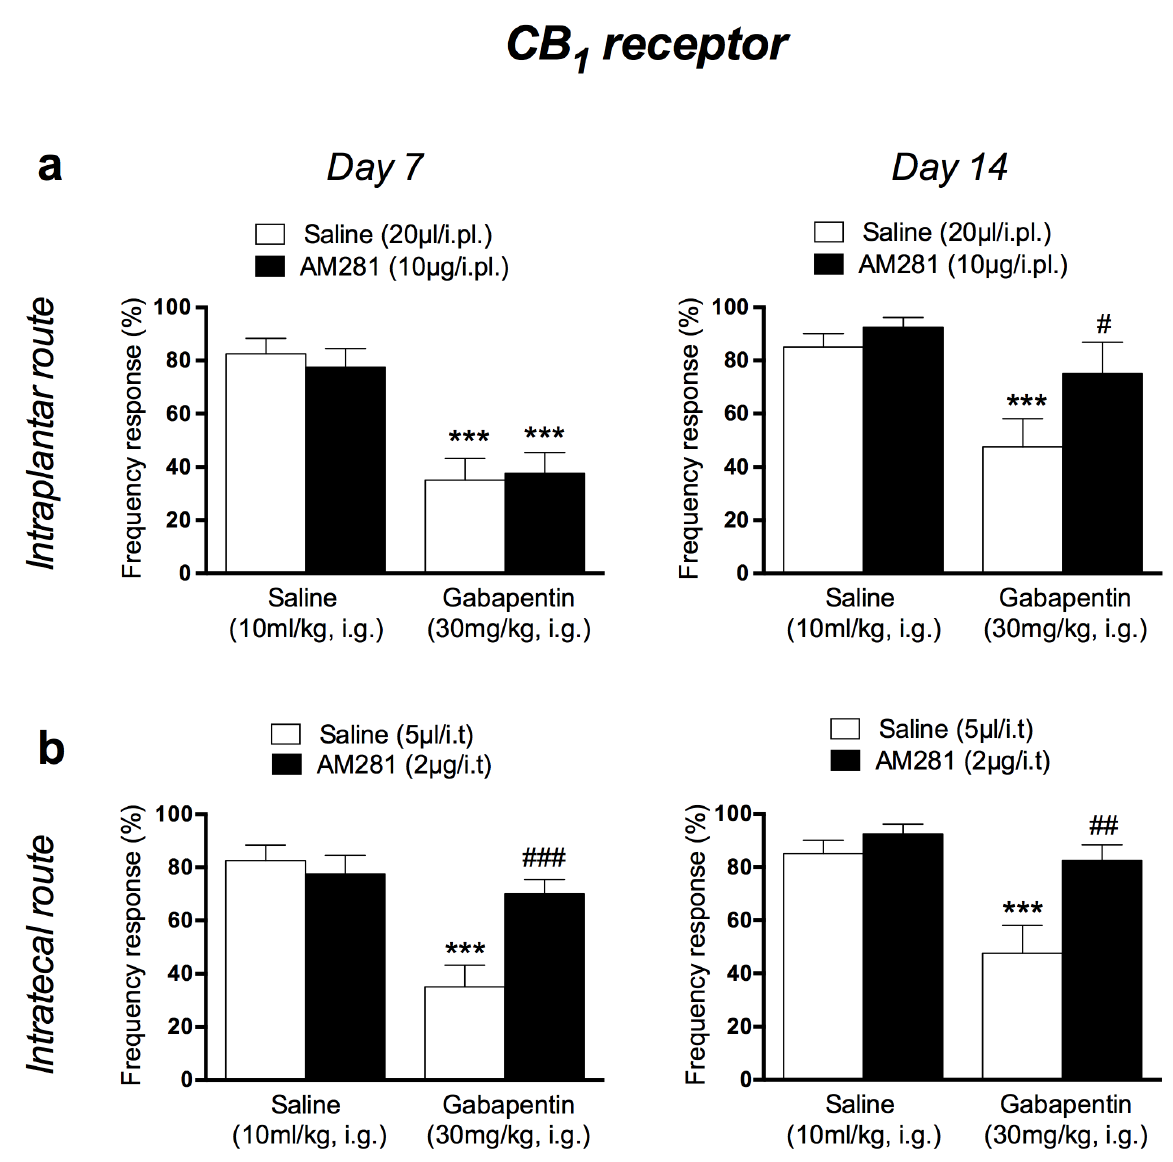
Figure 2. Influence of the CB antagonist, via i.pl. (panel A) or i.t. (panel B), on the antihyperalgesic effect of 1 gabapentin on the 7 th day and on the 14 th day after nerve injury induction in the PSL model in mice. Data are expressed as the mean ± standard error of the mean (SEM), n= 8 animals. (*) represents the comparison with the saline-saline group; (#) denotes the comparison with the salt-gabapentin group. Two-way ANOVA followed by Bonferroni, p<